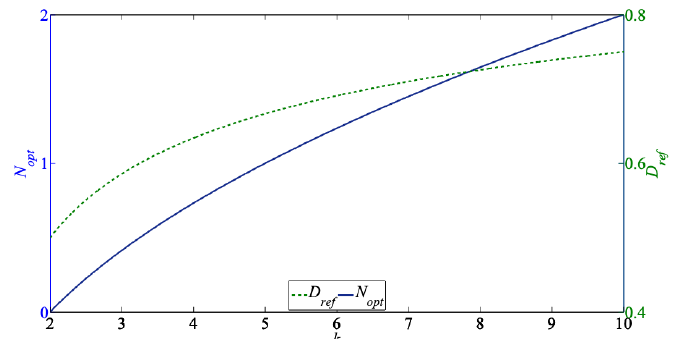
Figure 4. N opt and D ref vs. k over the interval k ∈ [2 ÷ 10].